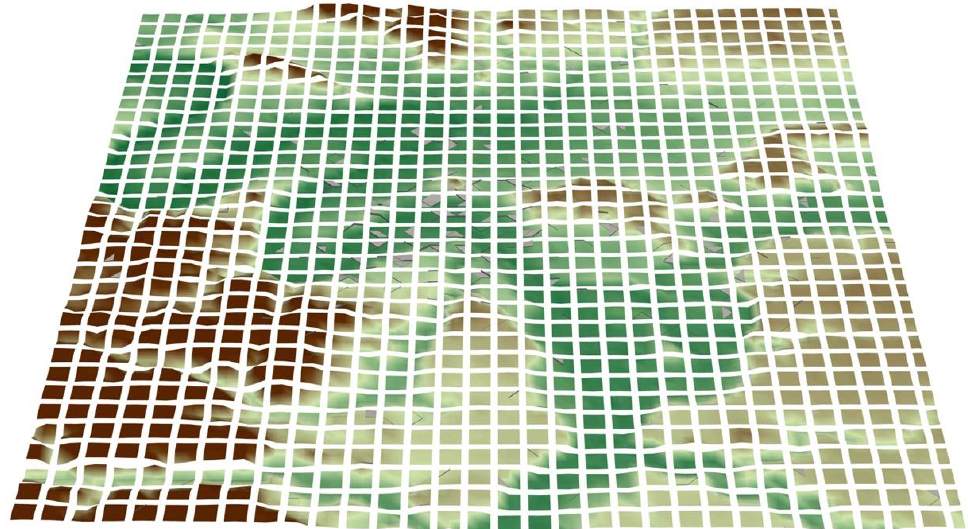
Figure 2. Domain decomposition of the domain in 1088 tiles.